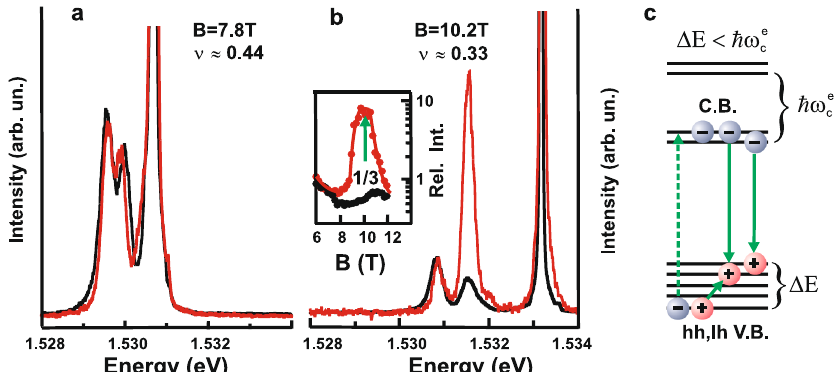
Fig. 2 Photoluminescence spectra for two values of electron fi lling factor. ν = 0.44 ( a ) and 1/3 ( b ), measured at two temperatures of the electron system: 0.5 K, required for the Laughlin state ν = 1/3 (red lines), and 1.6 K, where the Laughlin liquid ν = 1/3 is already destroyed (black lines). The photon excitation energy is 1.534 eV. Photoluminescence intensities are normalized by those of the lowest spin sublevel. The inset in b shows the amplitude ratio of photoluminescence signals from the upper and lower spin sublevels as a function of the magnetic fi eld at 0.5 K (red dots) and 1.6 K (black dots). The solid lines are added for convenience. The pictorial diagram c illustrates the process of excitation and recombination of the electron system. The electron is excited from a heavy (light) holes energy level (hh, lh) to the conductance band (C.B.) upper spin sublevel. The hole moves to its lowest-energy position and recombines with an equilibrium electron from the lower spin sublevel. The energy of the excitation radiation is chosen to be lower than that of the optical transition from the fi rst electron Landau level to the valence band V.B. (for a more detailed explanation, see Supplementary Materials).